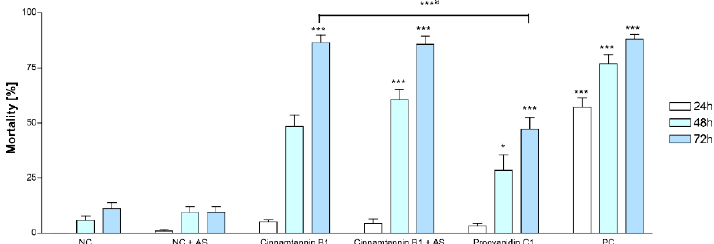
Figure 6. Effects of isolated cinnamtannin B1 ( 1 ) versus procyanidin C1 (epicatechin-(4 β → 8)-epicatechin-(4 β → 8)-epicatechin) at 1 mM on the viability of adult C. elegans with and without addition of 0.01% ascorbic acid (AS). NC: negative control (DMSO 1%), PC: positive control (levamisole-HCl 40 mM). Bars represent mean [%] ± SEM from at least 3 independent experiments ( n = 12). ***: p < 0.001; *: p < 0.05 compared to NC, or „a“: compared to procyanidin C1 (One-way ANOVA, Tukey- post-test).